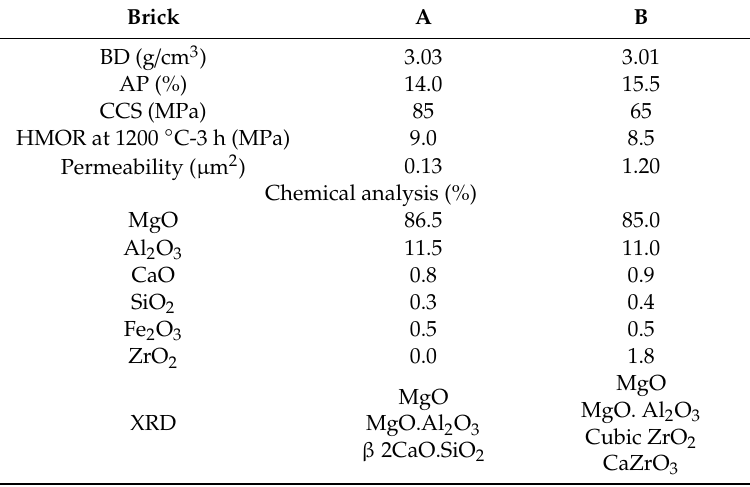
Table 2. Properties of magnesia–spinel bricks used in the coating tests.